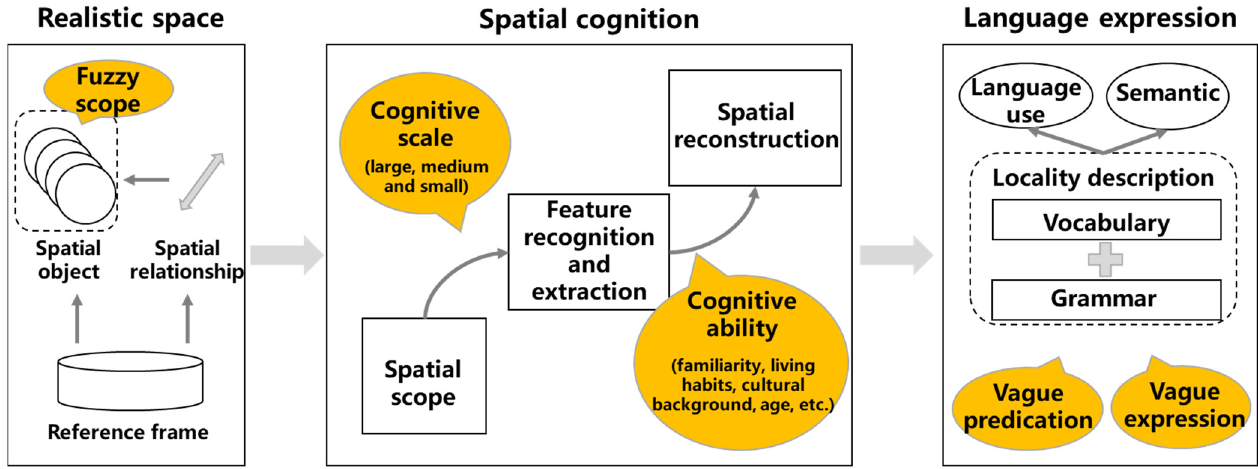
Figure 2. Source of vagueness in location